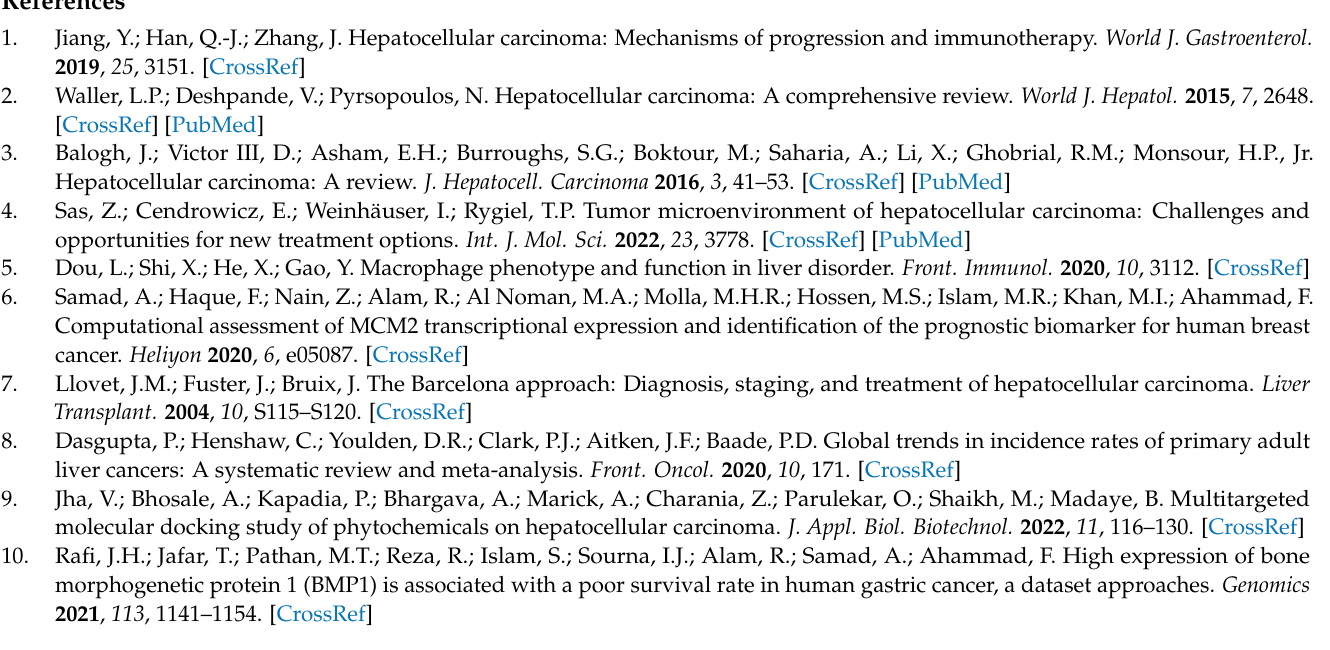
terns (b) of obamegine with EGFR as a receptor; Figure S3: Interactions (a) and binding patterns (b) of isotetrandrine with EGFR as a receptor; Figure S4: Interactions (a) and binding patterns (b) of liquoric acid with caspase-9 as a receptor; Figure S5: Interactions (a) and binding patterns (b) of 3-O-caffeoyloleanolic acid with caspase-9 as a receptor; Figure S6: Interactions (a) and binding patterns (b) of betulin with caspase-9 as a receptor; Figure S7: Root mean square deviation (RMSD) values of liquoric acid and limonin with receptor proteins (replicate). (a) RMSD of the C-alpha atoms of EGFR and liquoric acid; (b) RMSD of the C-alpha atoms of caspase-9 and limonin with time. The variation of protein RMSD is shown on left y axis through time. The variation of ligand RMSD is shown on right y axis through time; Figure S8: Protein secondary structure element (SSE) distribution by residue index throughout the protein structure of EGFR. Red indicates α -helices, and blue indicates β -strands; Figure S9: Protein secondary structure element (SSE) distribution by residue index throughout the protein structure of caspase-9. Red indicates α -helices, and blue indicates β -strands; Table S1: MM-GBSA-binding energy calculations of liquoric acid with EGFR after every ten nanoseconds from molecular dynamics simulation trajectories; Table S2: MM-GBSA-binding energy calculations of limonin with caspase-9 after every ten nanoseconds from molecular dynamics simulation